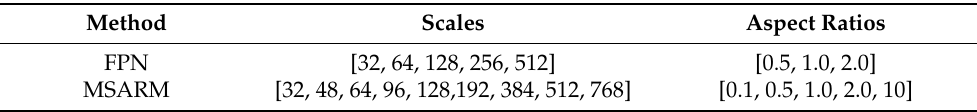
Figure 6. Aspect ratio and length distribution of damage in the dataset. Center of the image is joint distribution of aspect ratio and length. Top and rightmost parts are aspect ratio and length distribution, respectively. Table 2. Two anchor mechanisms used in training: feature pyramid network (FPN) and multi-scale and multiple aspect ratios mechanism